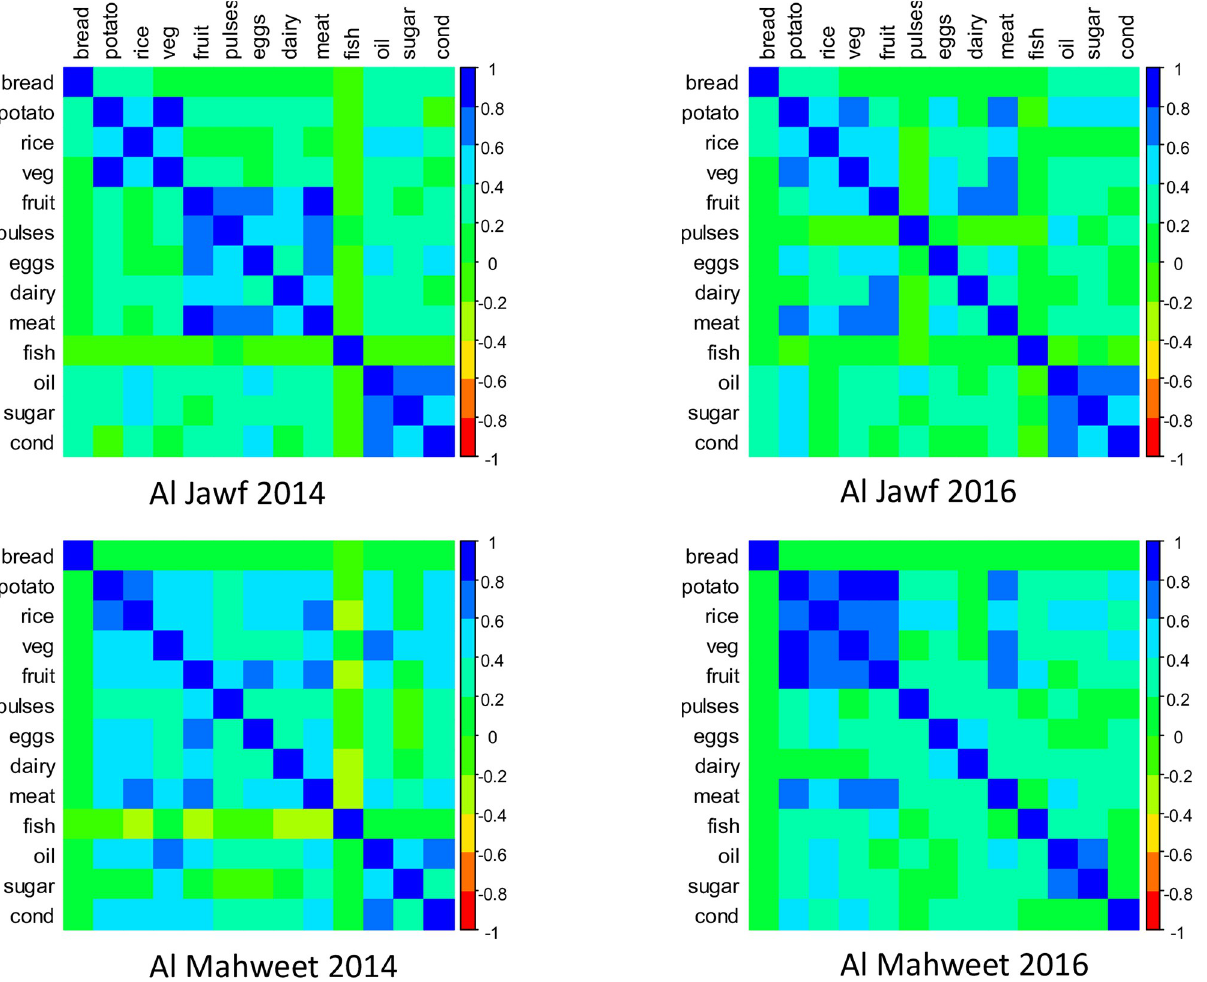
Fig 5. Estimated random effects correlation matrices in Al Jawf and Al